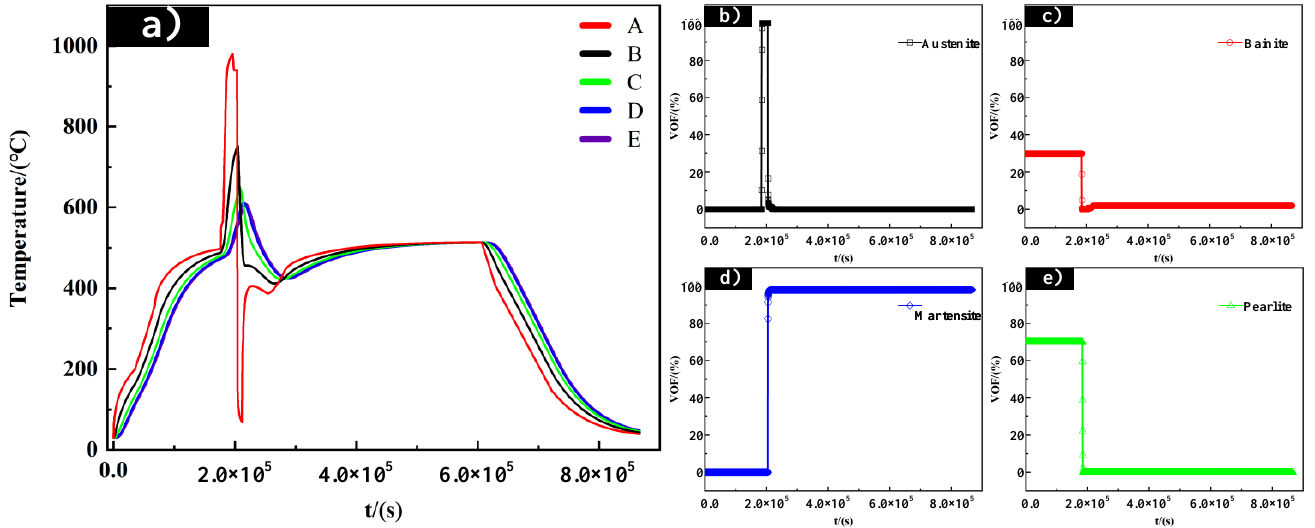
Figure 4. The temperature change diagram of heat treatment and the volume fraction of microstruc- ture at each point. ( a ) The temperature change at each point of A – E during the whole heat treatment process; ( b ) the change of volume fraction of austenite content at point A with time; ( c ) the change of volume fraction of bainite content at point A with time; ( d ) the change of volume fraction of martensite content at point A with time; ( e ) the change of volume fraction of pearlite content at point A with time.